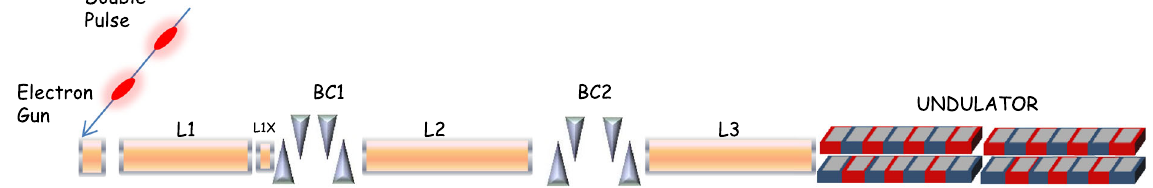
FIG. 1. A schematic layout of the two-bunch method to generate the two-color x-ray pulse (not to